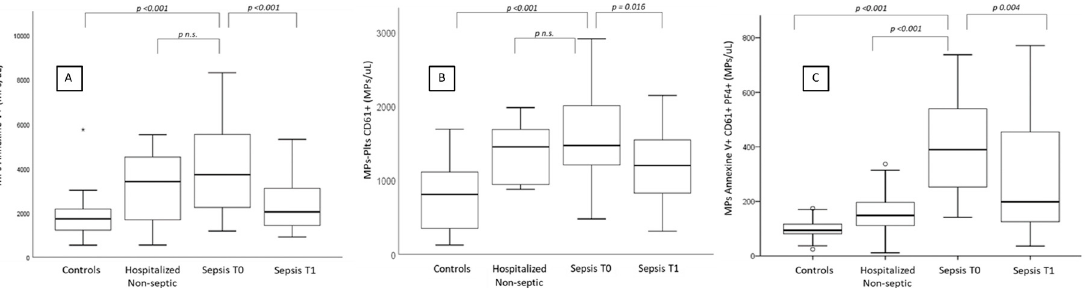
Figure 2. Numbers of microparticles ( A : annexin V + ), platelet-derived microparticles ( B : annexin V +/ CD61 + ) and platelet-derived microparticles bearing PF4 ( C : annexin V +/ CD61 +/ PF4 + ) in healthy controls, patients with acute disease without sepsis, and patients with sepsis, on admission (T0) and 7 ± 2 days afterwards (T1). Table 4. Levels of platelet-derived microparticles (annexin +/ CD61 + ) in patients with sepsis, on admission (T0) and at 7 ± 2 days afterwards (T1), and in control patients with acute non-septic disease, and healthy controls.